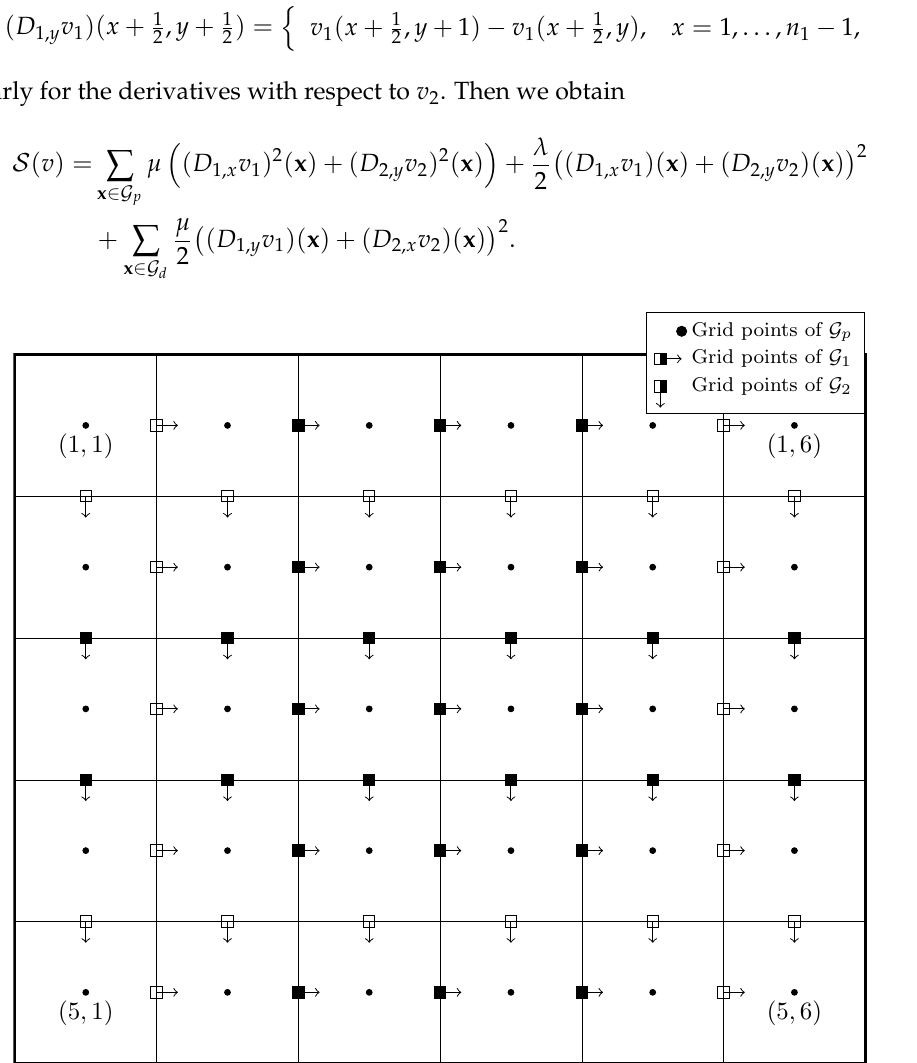
Figure 2. Illustration of the grids, where empty boxes mean zero